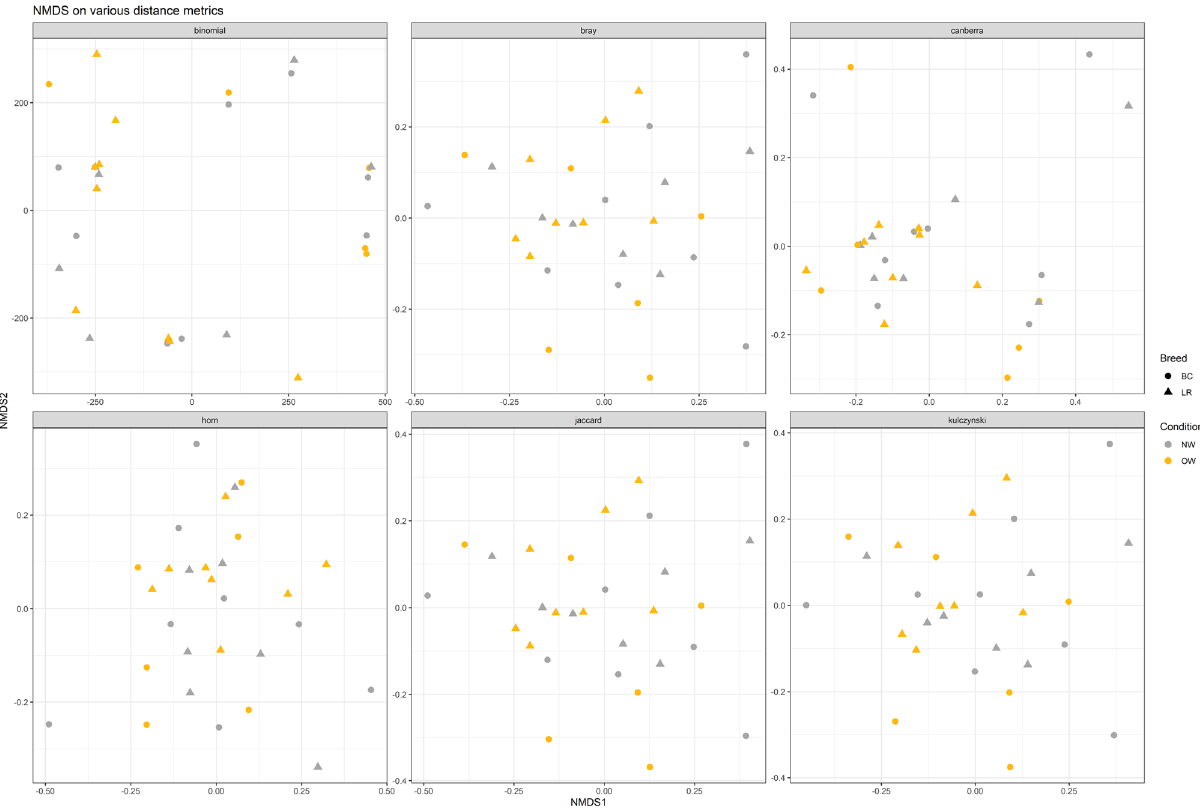
Figure 4. Non-metric multidimensional scaling (NMDS) plot based on six different beta measures generated at ASV level by condition (lean, NW, n = 15; overweight, OW, n = 14) and breed (Labrador Retrievers, LR, n = 15; Border Collies, BC, n = 14). Dots represent breed and colours indicate body condition. Dogs’ names were used to distinguish the analysed samples. No plot showed a clustering among groups. This figure was created using R version 3.4.3 (https:// www.r- proje ct. org).